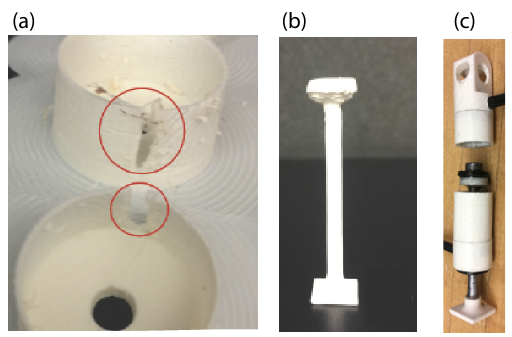
Figure 9. A few failed actuator scenarios: ( a ) Actuator cylinder cracked after acetone treatment due to too thin wall ( b ) A 3D printed actuator piston after acetone treatment became rubberized and relatively week after an incorrect dip time, and ( c ) Actuator cracked in the transverse direction after high pressure but low cycling